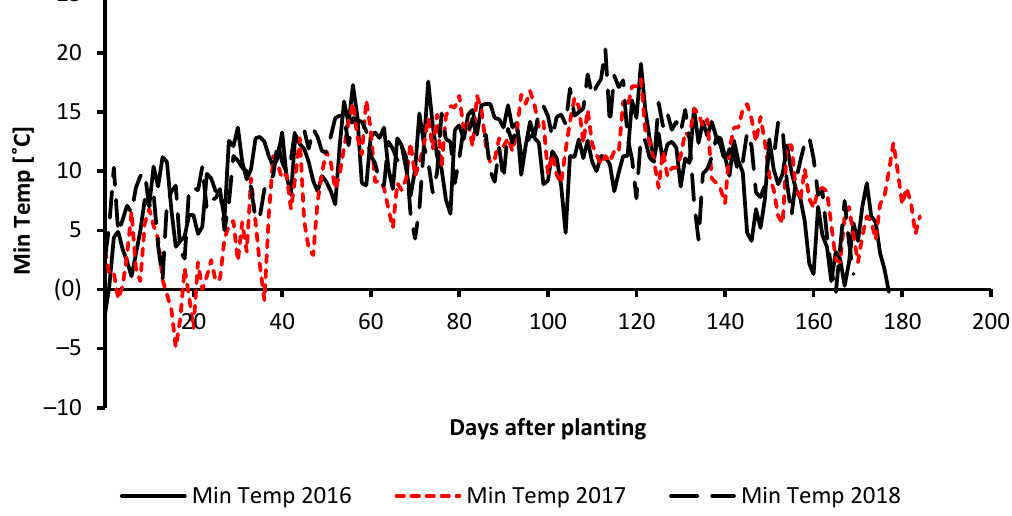
Figure 1. Daily minimum temperatures (Min Temp) (°C) observed at the weather station near to the sugar beet field experiment (2016–2018).